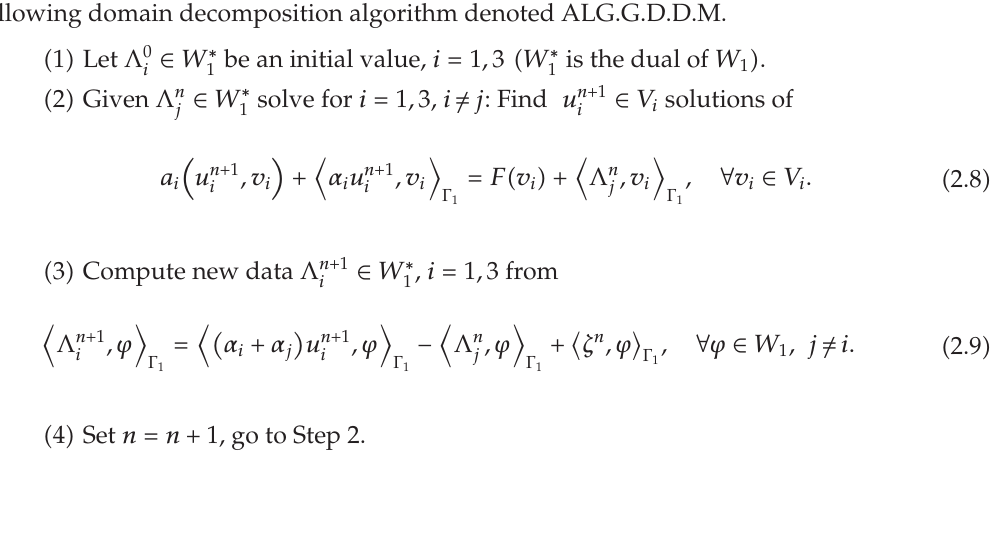
(cid:2) 2.2 (cid:3) , (cid:2) 2.3 (cid:3) satisfy